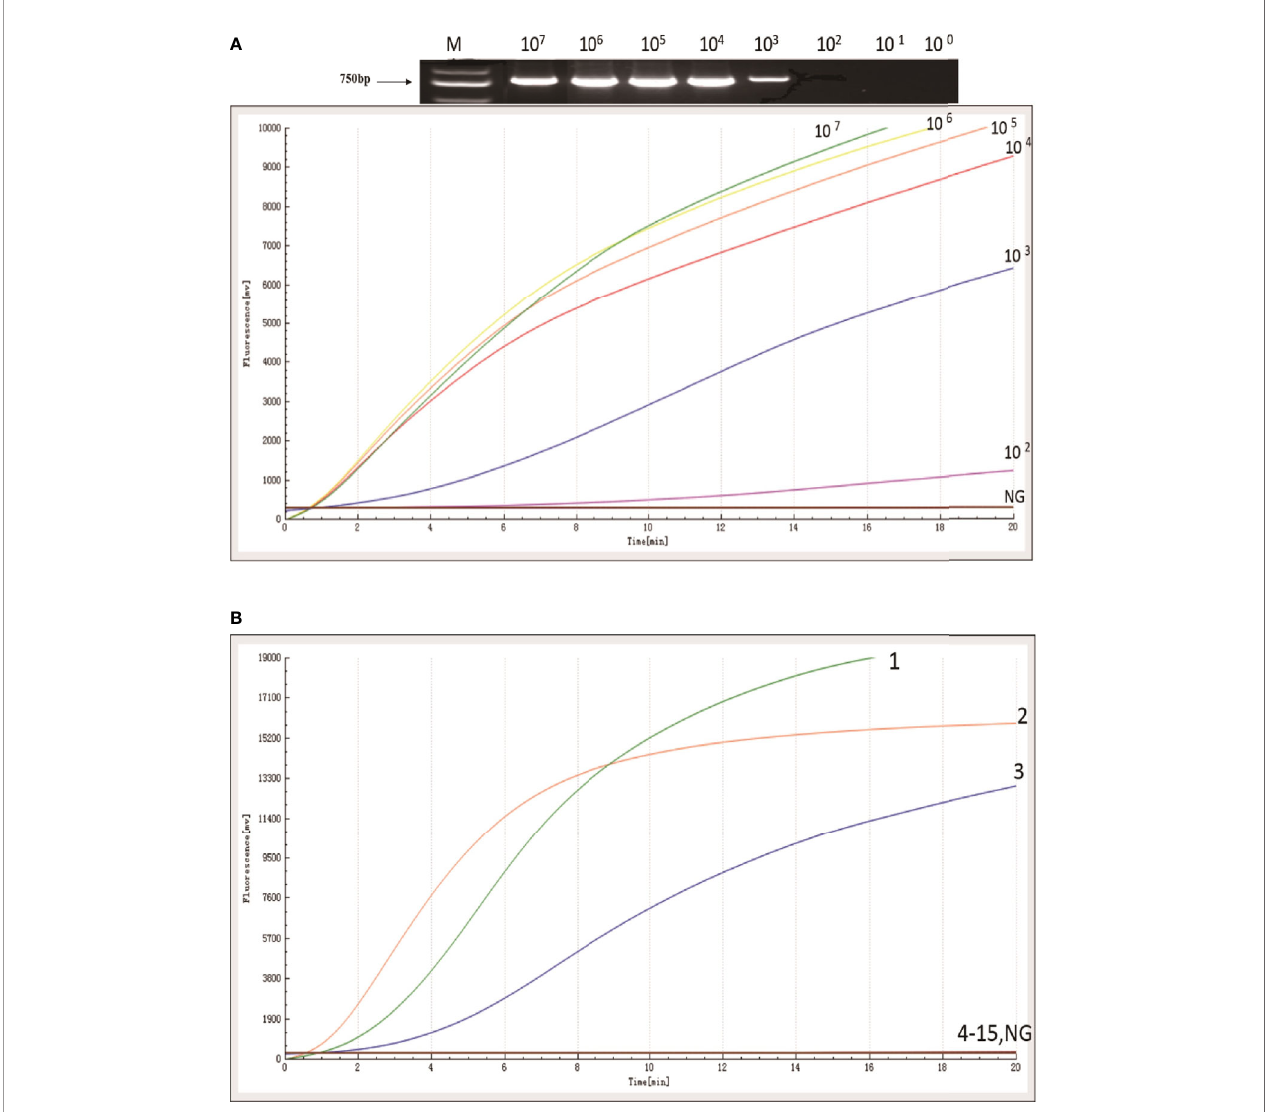
FIGURE 2 | Sensitivity and speci fi city of RAA assay. (A) An increase in the fl uorescence signal was observed from 1×10 7 to 1×10 2 copies/reaction. (B) Kpn ATCC1705, Acinetobacter baumannii , and Pseudomonas aeruginosa produced ampli fi cation signals (1, 2, and 3), while the other KPC negative bacterial strains (4-15) and negative control were